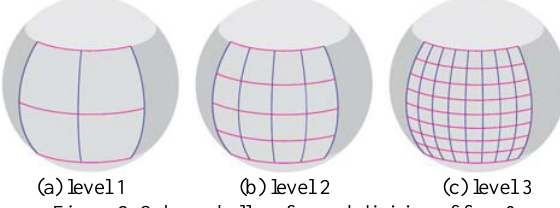
Figure 2. Sphere shell surface subdivision of face 0